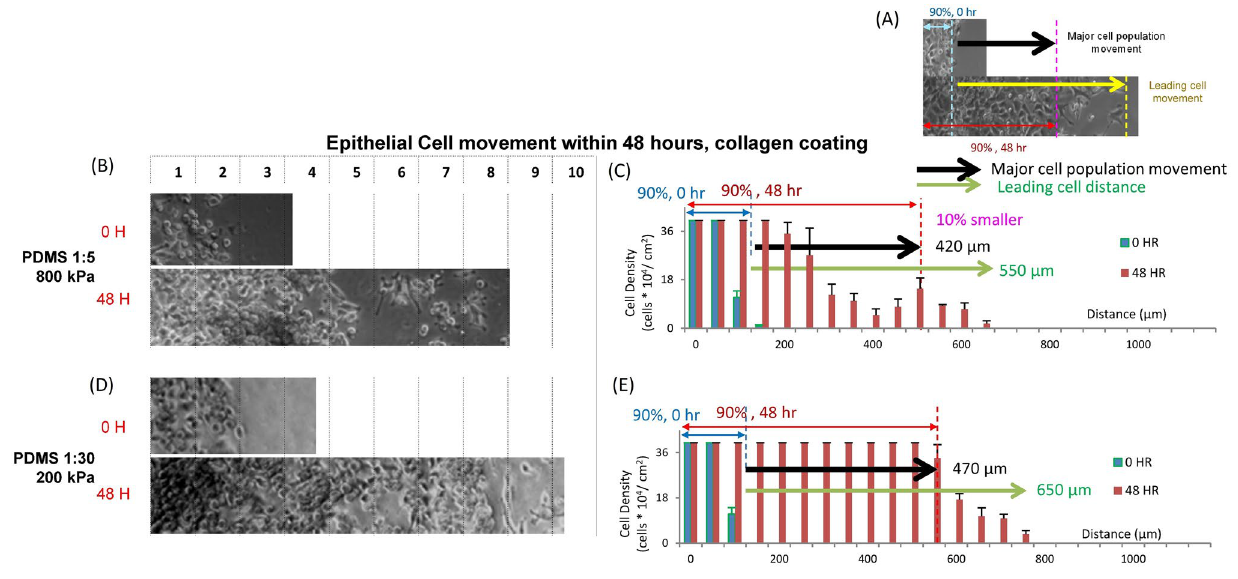
Figure 2. The motility of A549 epithelial cells on collagen coated PDMS substrates with different stiffnesses. ( A ) A diagram to indicate collagen coated PDMS substrates with different stiffnesses. Images and quantitation, respectively, of the movement of A549 epithelial cells attached on PDMS substrates with stiffnesses including ( B , C ) 800 kPa and ( D , E ) 200 kPa at 0 h and 48 h after they were released. Data are standard deviation with total cell counts = 4379 and n = 3.